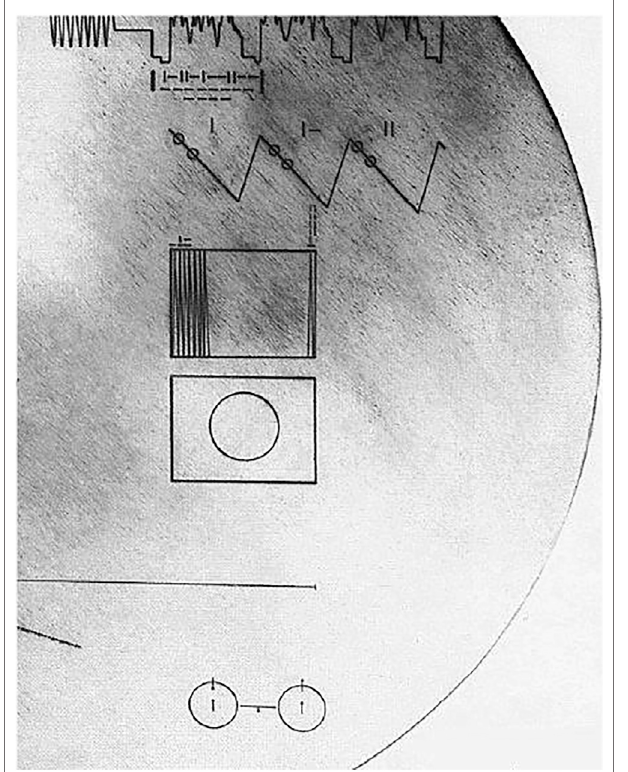
FIGURE 13 | The Pulsar Map and Hydrogen Symbol. Segment of the Voyager message inscription (1977). Credit: NASA.